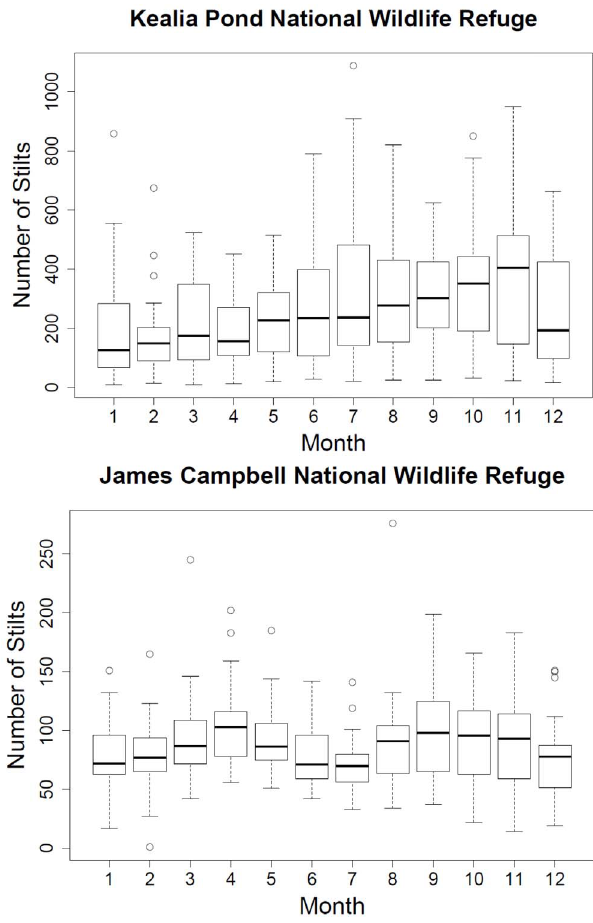
Figure 3. Seasonal use by Hawaiian Stilts on two national wildlife refuges in Hawai’i, USA for the time period spanning 1989–2008. The box represents the upper (75%) and lower (25%) quartiles, the horizontal line in the box shows the median, and vertical dashed lines (whiskers) indicate either the maximum and minimum values or 1.5 times the interquartile range (2 standard deviations). Data beyond the end of the whiskers are outliers and plotted as hollow